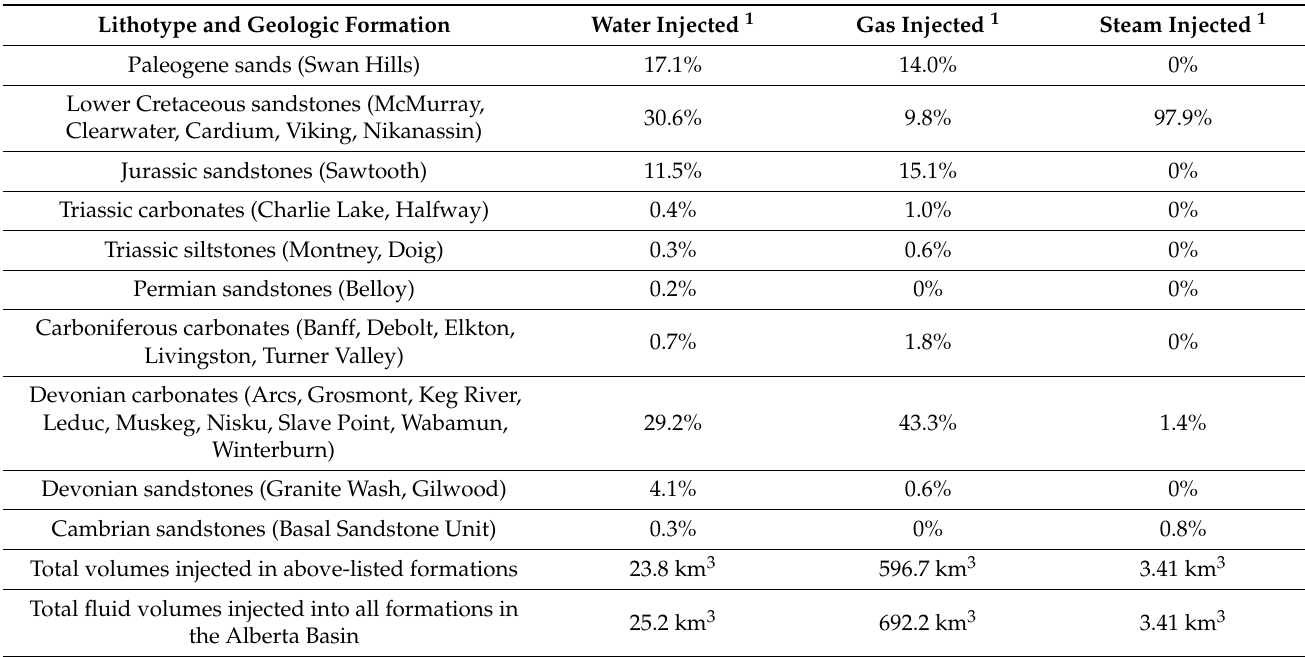
Table 1. Key recipient formations for all types of fluid injection in the Alberta Basin over the period January 1962 to December 2021. After Samaroo et al. (2022) [13] and used with permission. Detailed production/injection and net fluid balance data for these formations are contained in Samaroo et al. (2022)